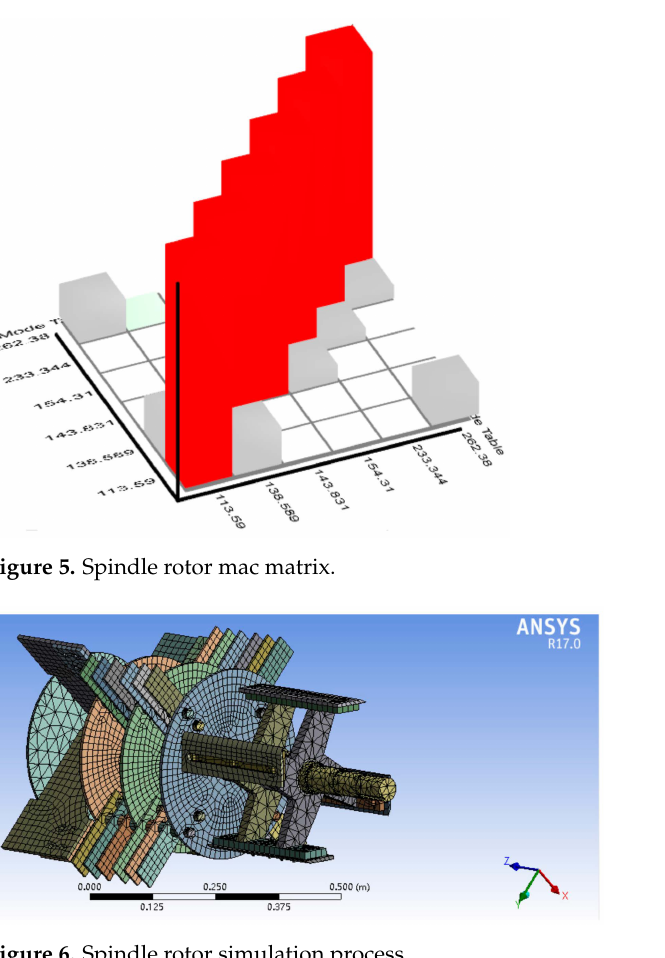
Figure 6. Spindle rotor simulation process.